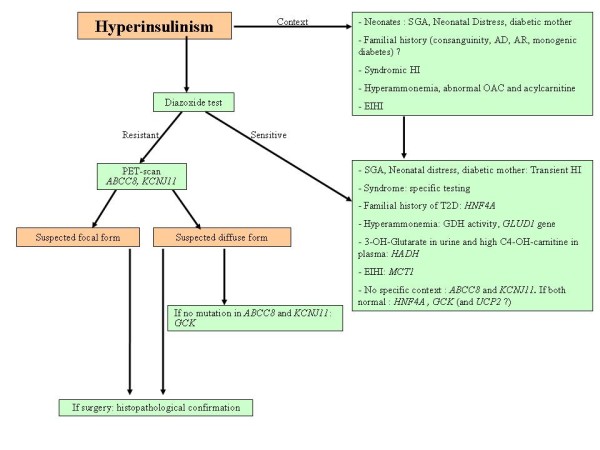
Diagnostic tree for HI. AD: Autosomal Dominant; AR: Autosomal Recessive; MODY: Maturity Onset Diabetes of the Youth; HI: Hyperinsulinism; OAC: Organic Acid Chromatography; EIHI: Exercise-Induced HyperInsulinism; SGA: Small for gestational age. T2D: Type 2 diabetes.